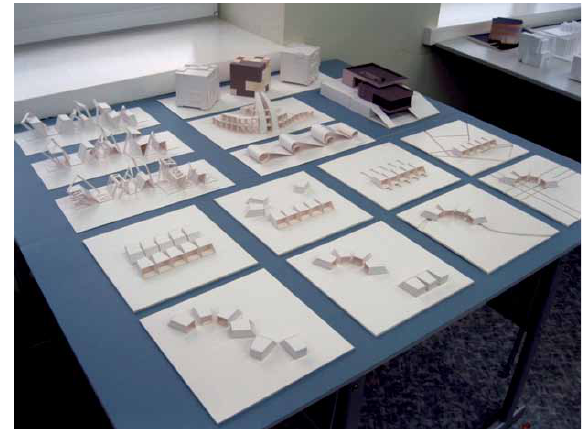
fig. 3. Tasks of architectural composition made by one student in one semester: many small tasksk help to develop skills of architectural